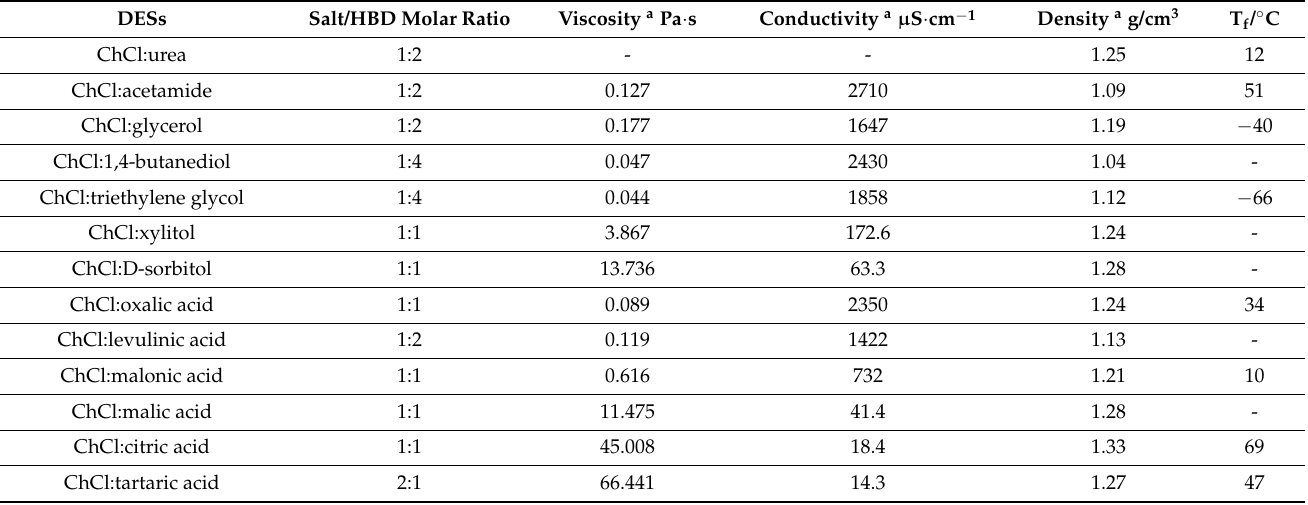
Table 1. Physical parameters of some ChCl-based